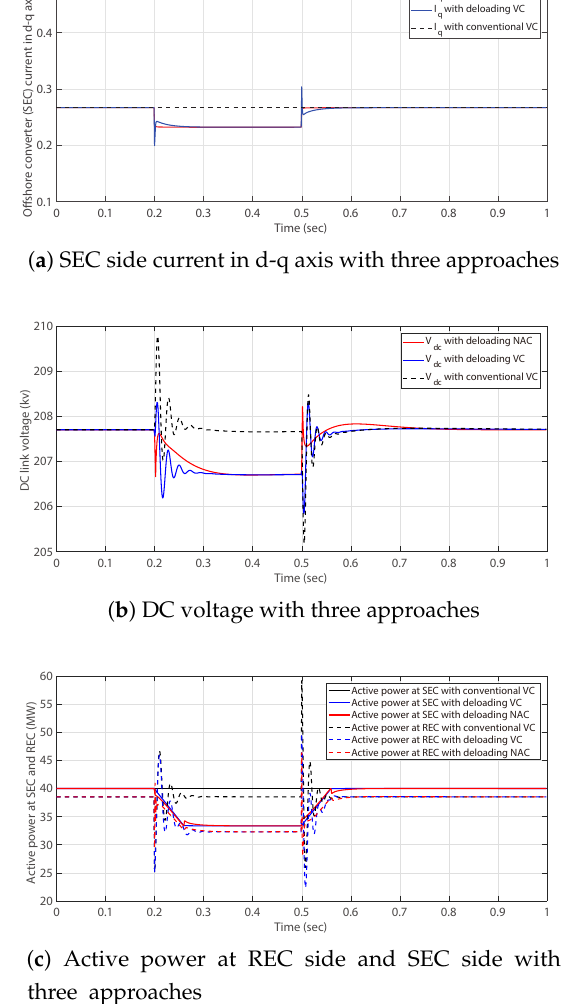
Figure 7. System responses obtained through SEC with 35% voltage sag at onshore AC grid.